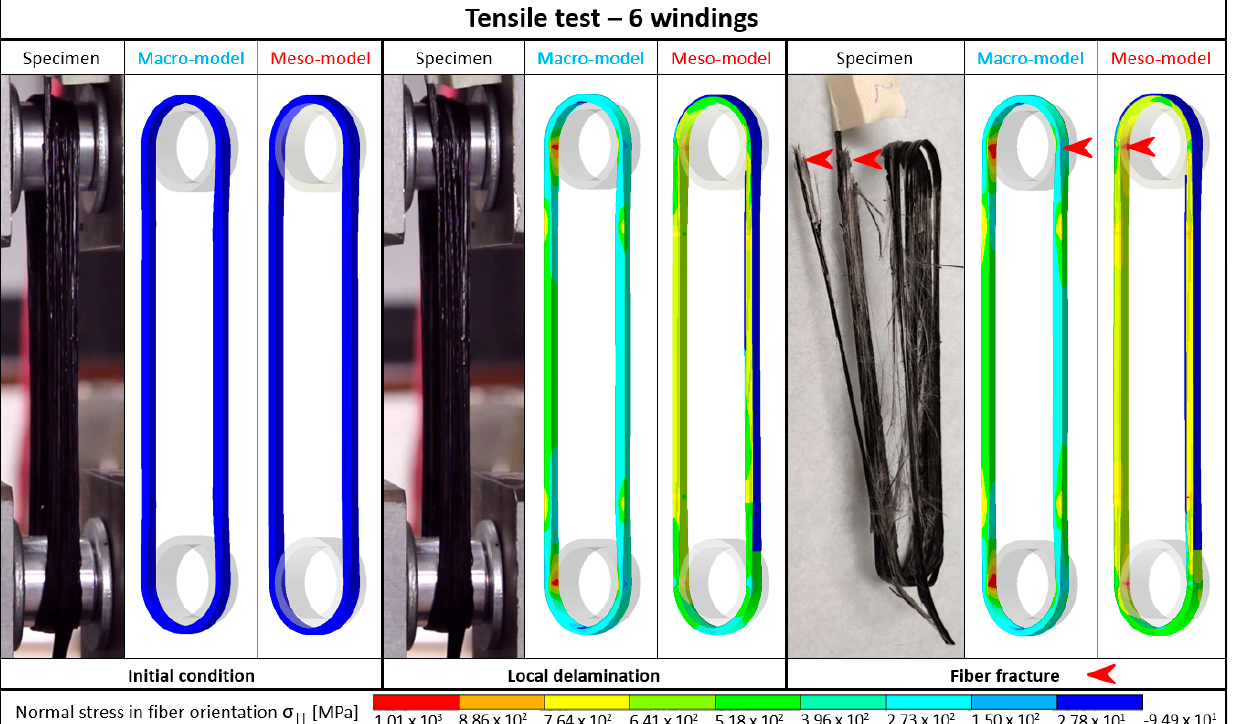
Figure 19. Load-displacement curves from tensile tests on simple loops with six windings (meas- ured and calculated).